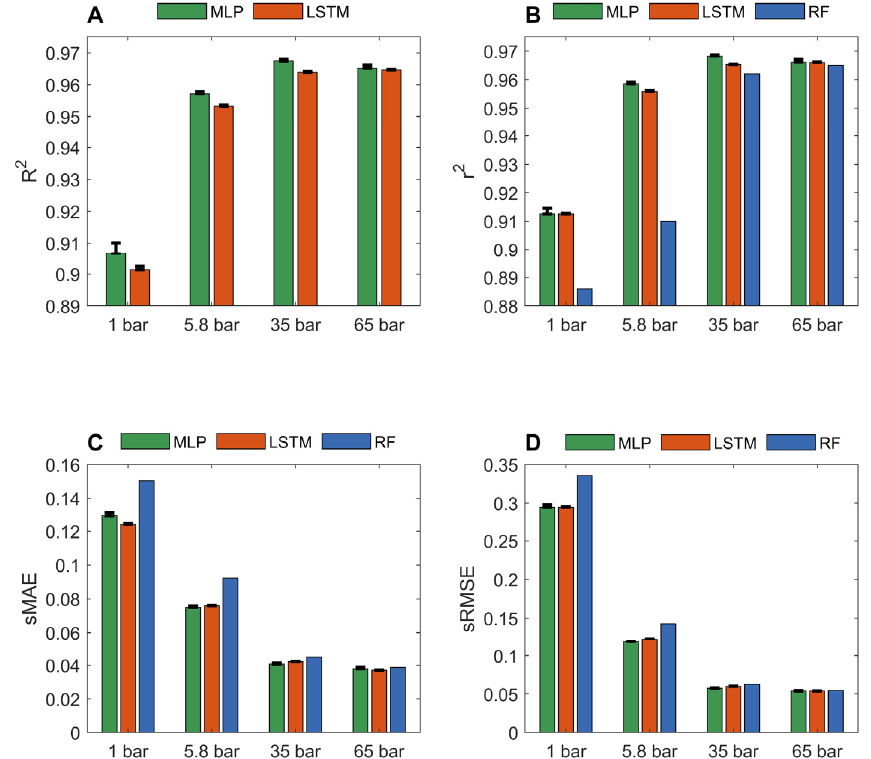
Figure 1. Performance of MLP and LSTM models in the 10-fold cross validations. Pressures at which adsorptions were predicted are marked by x-axis tick labels. Performance was measured in R 2 ( A ); r 2 ( B ); sMAE ( C ); and sRMSE ( D ) and depicted on the y-axes. The average performance measurement values are given in red and green bars for LSTM and MLP models, respectively. The corresponding standard deviations are plotted as sticks above the bars. The results of random forest models from the same datasets reported in Fanourgakis et al.’s JACS paper [36] are plotted as the blue bars.